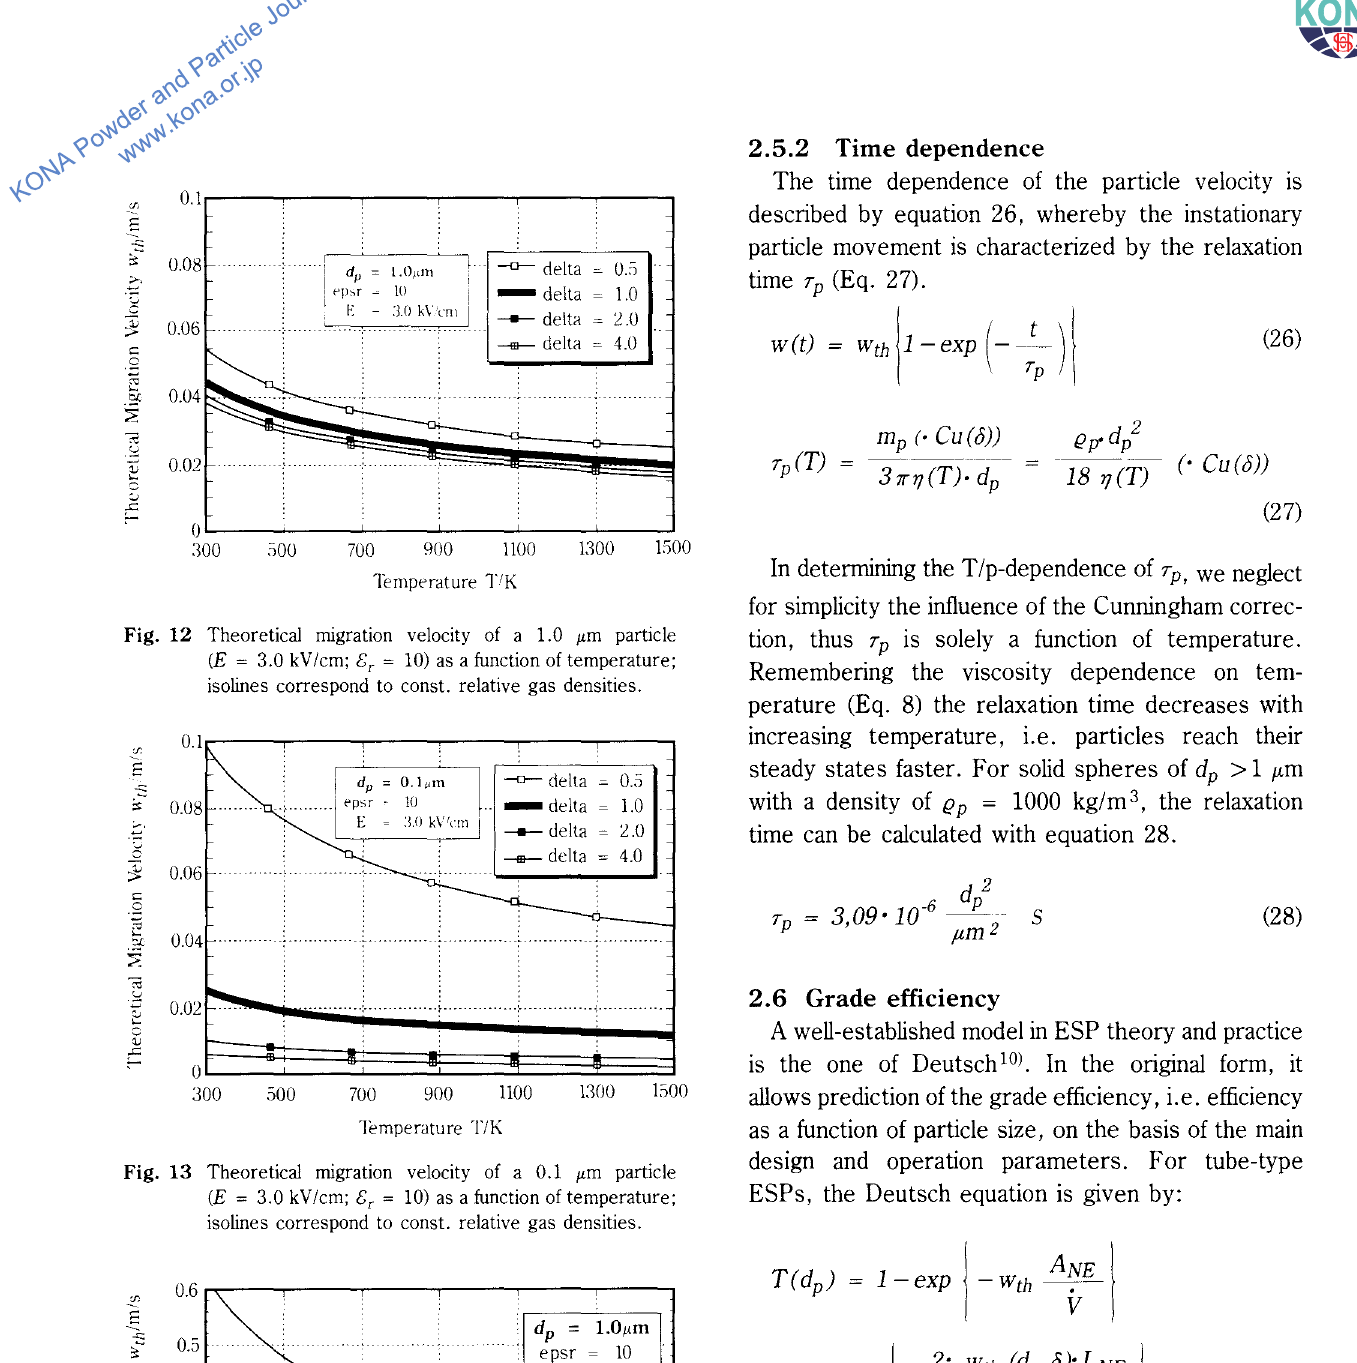
Fig. 13 Theoretical migration velocity of a 0.1 I'm particle (E = 3.0 kV/cm; 6r = 10) as a function of temperature; isolines correspond to const. relative gas densities.